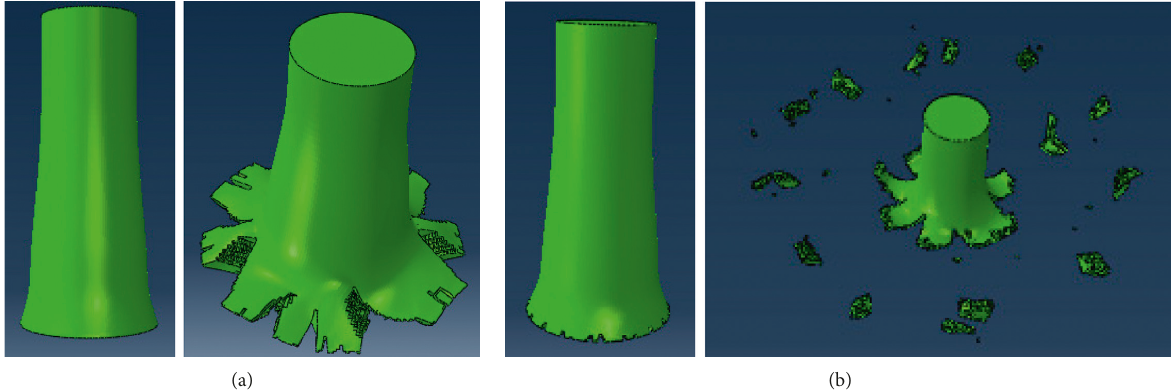
Figure 2: Predicted results using the piecewise linear model. (a) The first group of parameters. (b) The second group of